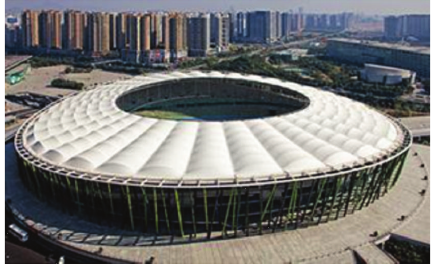
Figure 2: Shenzhen Baoan Stadium,